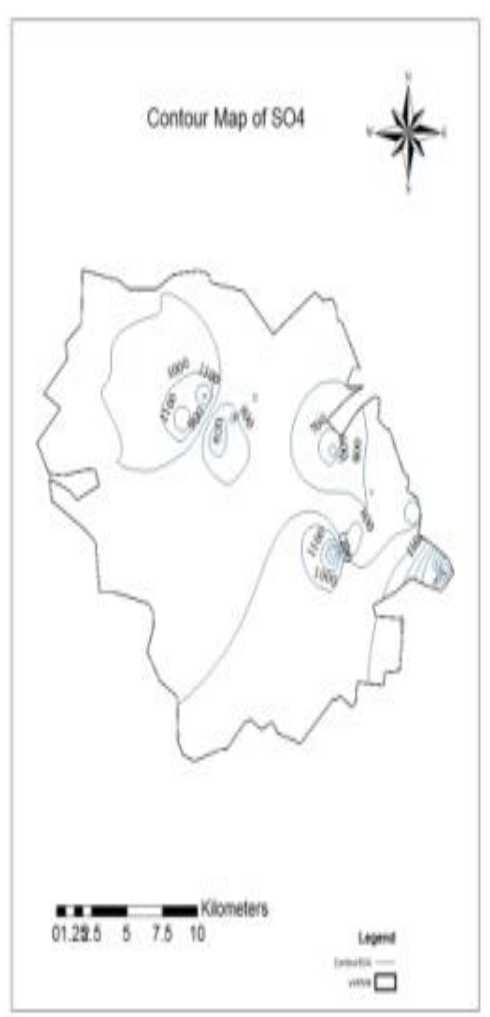
Fig.10: The interpolation and contour line of SO map in ppm. 4